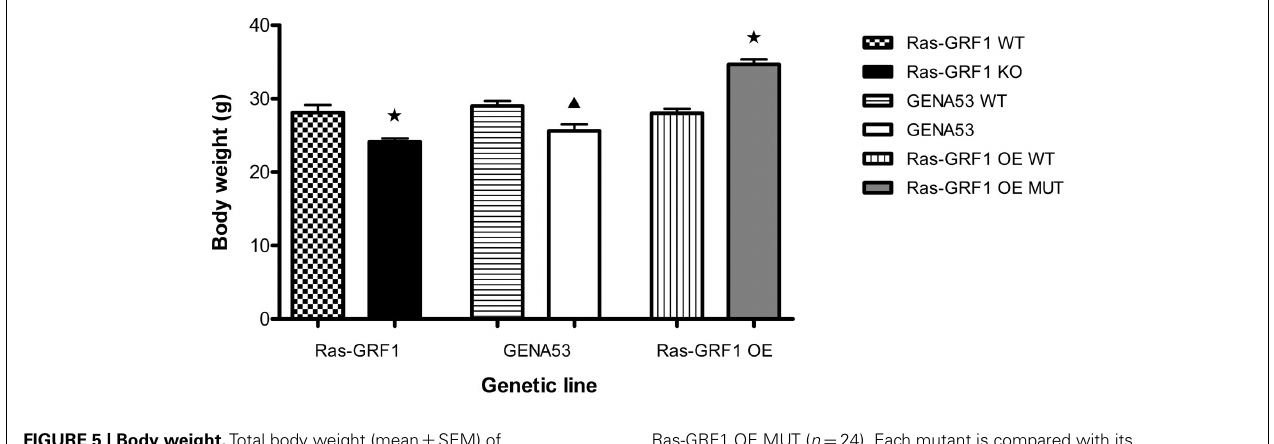
FIGURE 5 | Body weight. Total body weight (mean ± SEM) of adult mice from the three genetic lines Ras-GRF1, GENA53, and Ras-GRF1 OE. Ras-GRF1WT ( n = 24); Ras-GRF1 KO ( n = 24); GENA53WT ( n = 24); GENA53 ( n = 24); Ras-GRF1 OEWT ( n = 24);